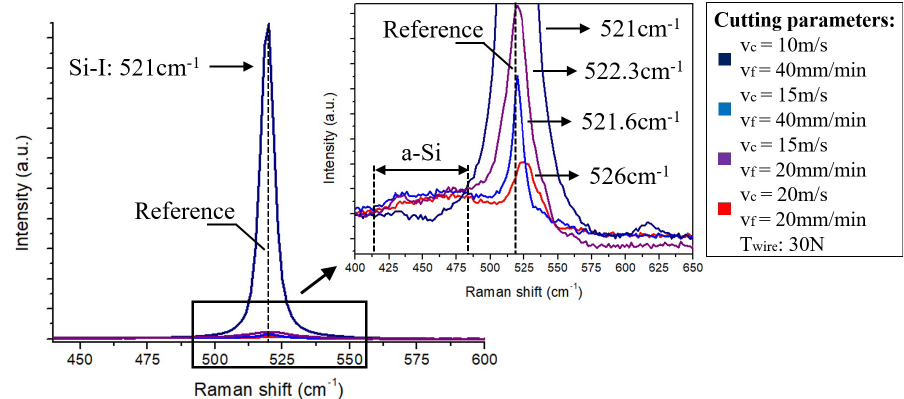
Figure 9. Displacement in the Si-I phase peak of the Raman spectra.